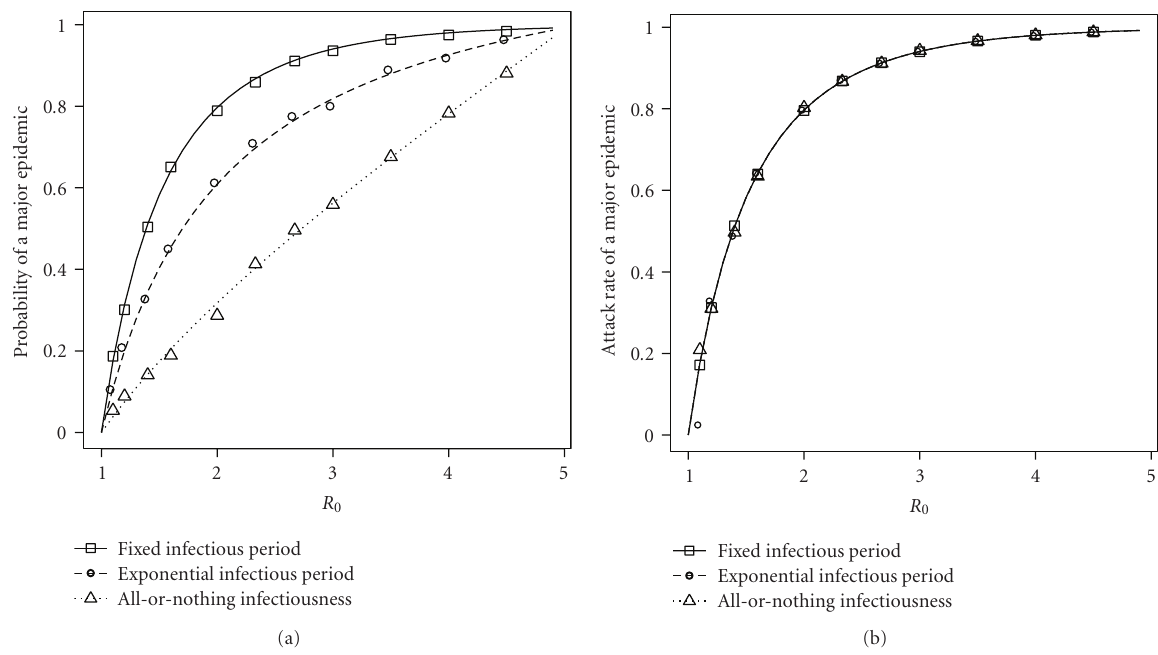
Figure 3: Major epidemic probabilities and attack rates in network-based models from Section 3.2. Lines represent theoretical predictions based on EPNs and symbols represent observed probabilities and attack rates in simulations. The observed probability of a major epidemic is based on 1,000 runs of each model, where a major epidemic was defined as having a final size ≥ 250. The observed attack rate is based on a single major epidemic. All models have a population of size 50,000 and an Erd˝os-R´enyi contact network with mean degree 5. The predicted probability and attack rate of a major epidemic are equal only when the infectious period is fixed.